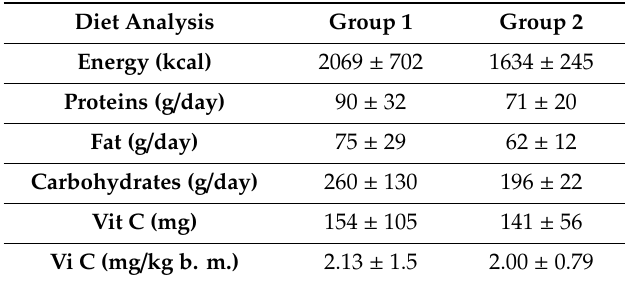
Table 3. Average daily energy values and nutrients of the female diet.